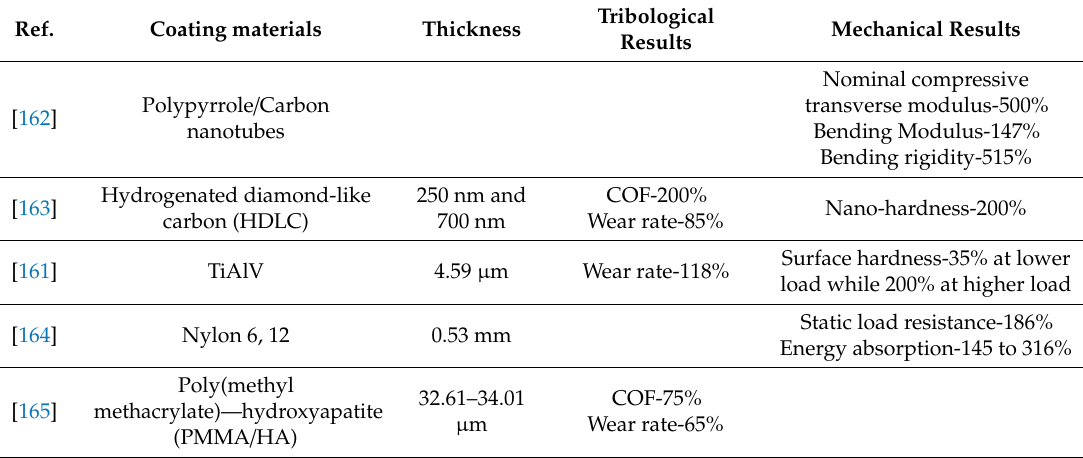
Table 4. E ff ect of coating on tribological and mechanical Table 4. Effect of coating on tribological and mechanical performance.